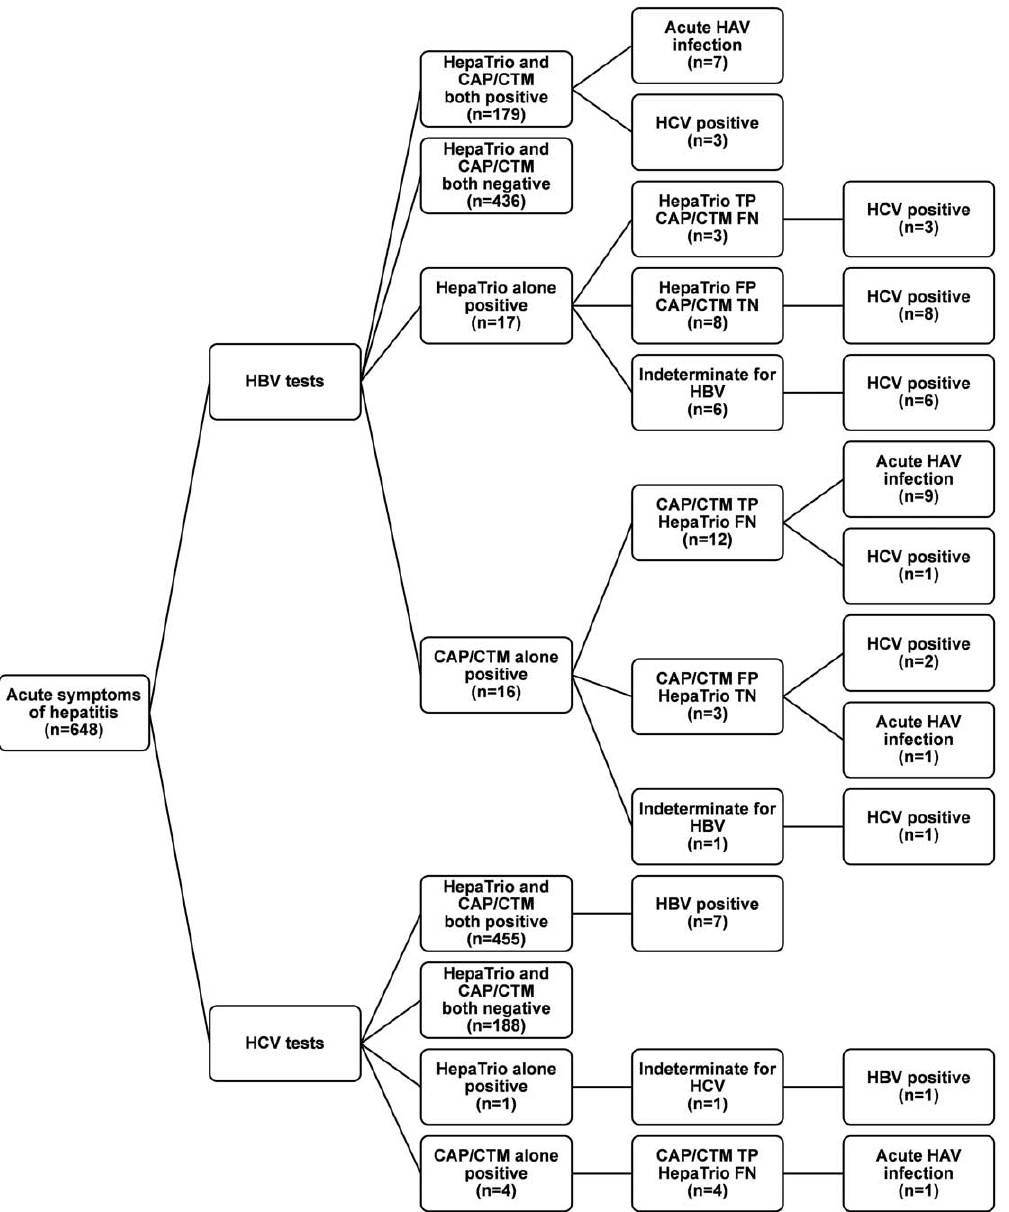
Figure 1. Results of the HepaTrio and the Cobas H AmpliPrep/Cobas H TaqMan H (CAP/CTM) HBV and HCV tests. For discrepant cases between the HepaTrio and the CAP/CTM tests, medical records including the results of serologic tests were reviewed. TP, true positive; FN, false negative; FP, false positive; TN, true negative.